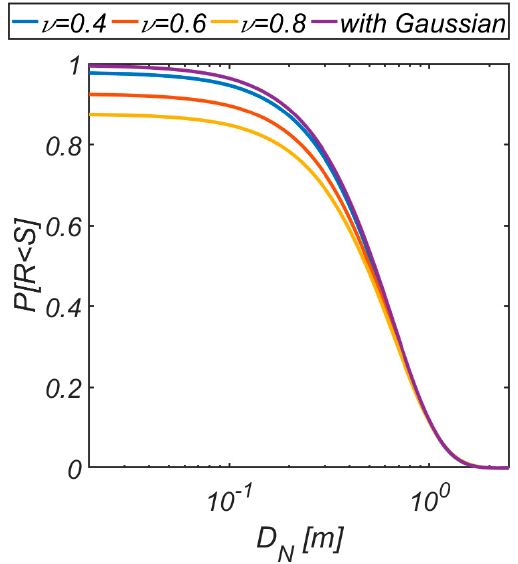
Figure 20. Comparison of failure probability of TTP based on the wave slope distribution derived in this study as D n varies with its corresponding Gaussian distribution [ ν =